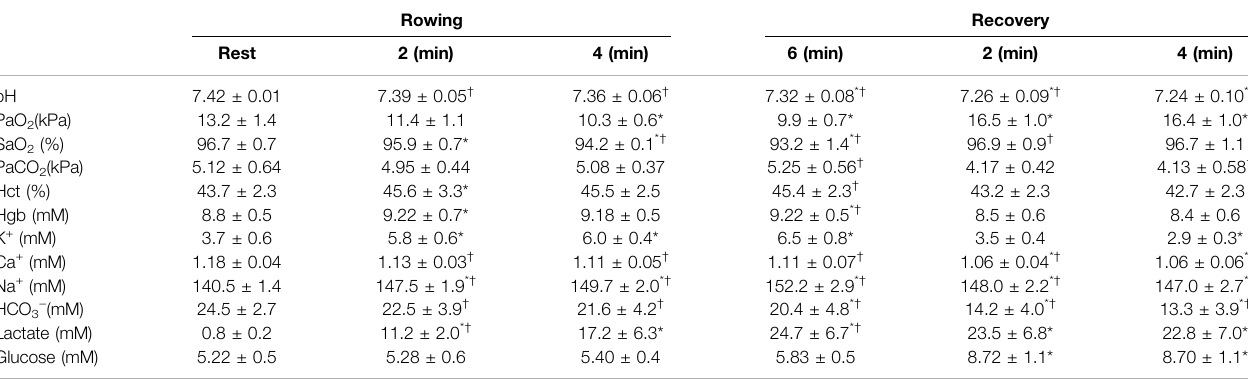
TABLE 3 | Blood variables during and after maximal ergometer rowing with infusion of bicarbonate. Rowing Recovery